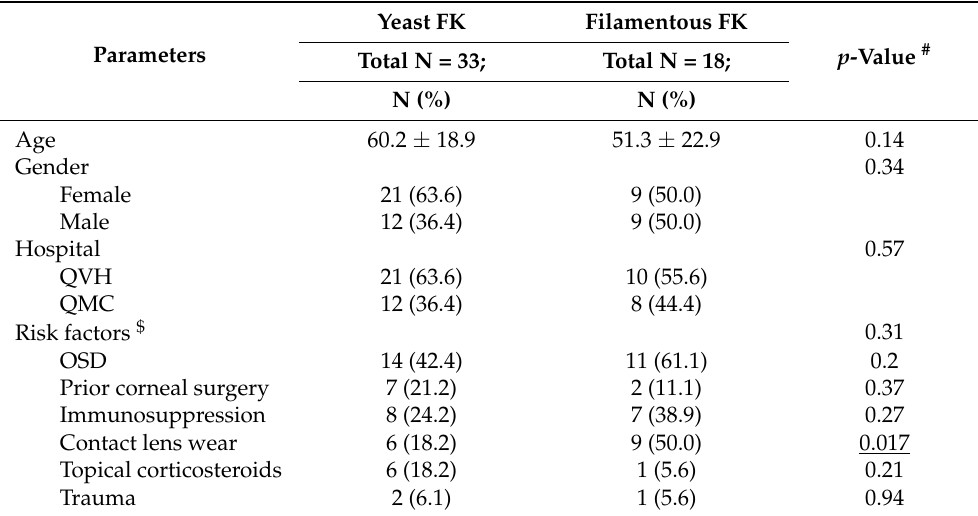
Table 3. Summary of demographic factors and risk factors based on types of fungal keratitis